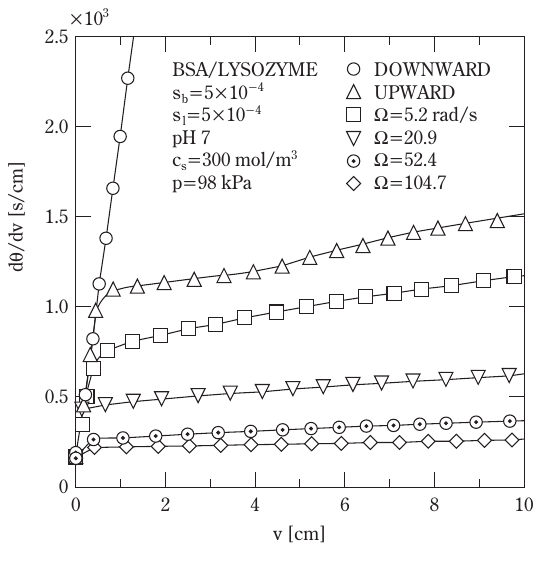
Fig. 25 Effect of hydrodynamics above membrane on filtration rate.